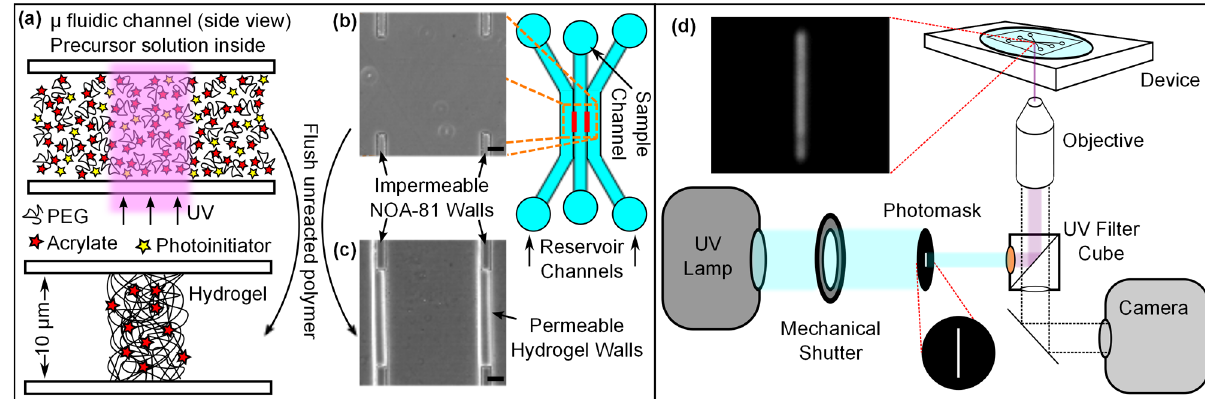
FIG. 1. Fabrication of HMMs. (a) A UV-polymerizable solution of poly(ethylene-glycol)-diacrylate and photoinitiator initially fills a three-channel microfluidic device (b), with gaps in the walls between channels. Patterned UV light is used to cross-link the hydrogel in two specified rectangular regions (width: 10 – 20 (cid:1) m ) filling the gaps in the walls. (c) After flushing the unreacted solution, hydrogel microwindow membranes remain (phase contrast, scale bar ¼ 20 (cid:1) m ). (d) Simplified microscope schematic for fabricating HMMs. The microfluidic device is placed on the microscope stage, and a photomask is inserted into the microscope field aperture. A computer- controlled mechanical shutter exposes the PEG-DA solution to UV irradiation for the desired exposure time. Inset: Natural fluorescence of NOA-81 optical glue enables the patterned UV light to be